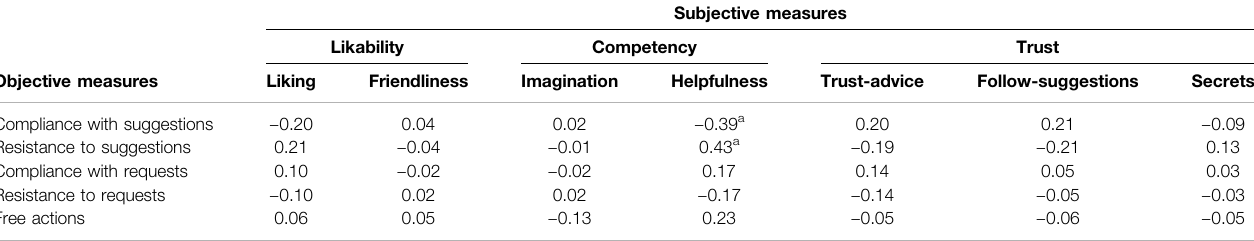
TABLE 5 | Spearman ’ s rank correlations of subjective measures with objective